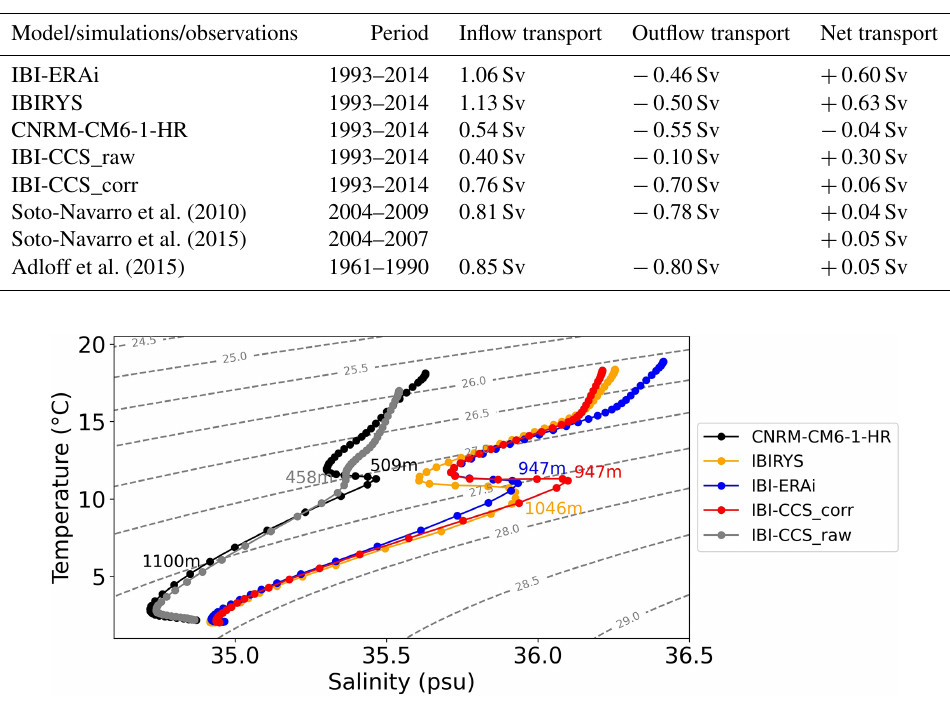
Figure 5. TS diagram performed at the star location of Fig. 1 over the 1993–2014 period for the CNRM-CM-1-HR, IBIRYS, IBI-ERAi, IBI-CCS_corr, and IBI-CCS_raw